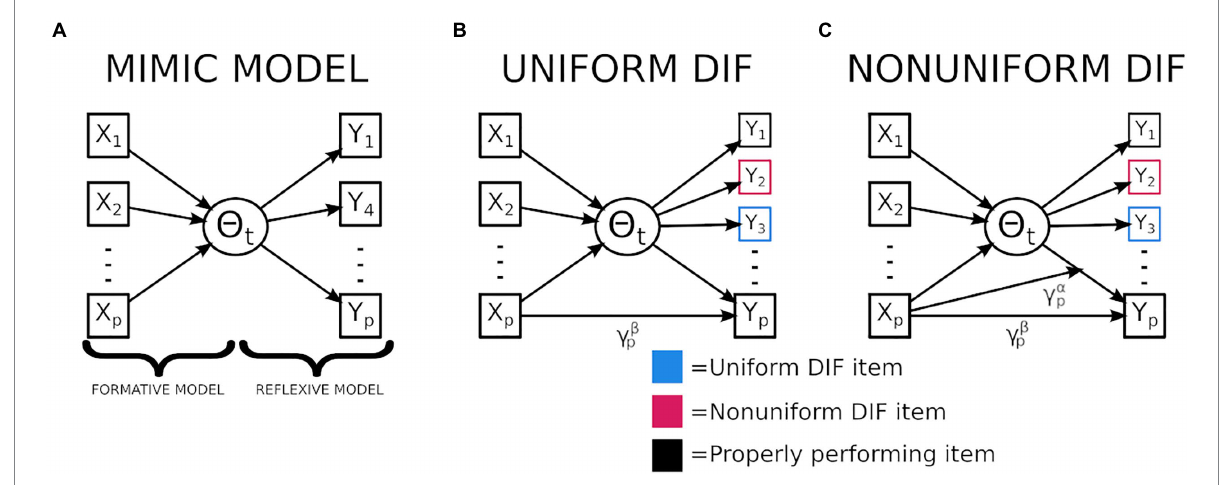
FIGURE 1 Graphical representation of a multiple indicator multiple cause (MIMIC) model and MIMIC models exploring differential item functioning (DIF). (A) Displayed is the MIMIC model which is composed of a formative (causal) and a reflexive (measurement) model. (B) Displays the mechanism used to assess for uniform DIF, notably the mediator is the latent variable which is believed to be the mechanism linking the causal and indicator variables. When the gamma path is not fully mediated then uniform DIF is present. (C) Displays the mechanisms used to assess nonuniform DIF, notably, when the relationship between the latent variable and an individual indicator varies as a function of the causal variable nonuniform DIF is